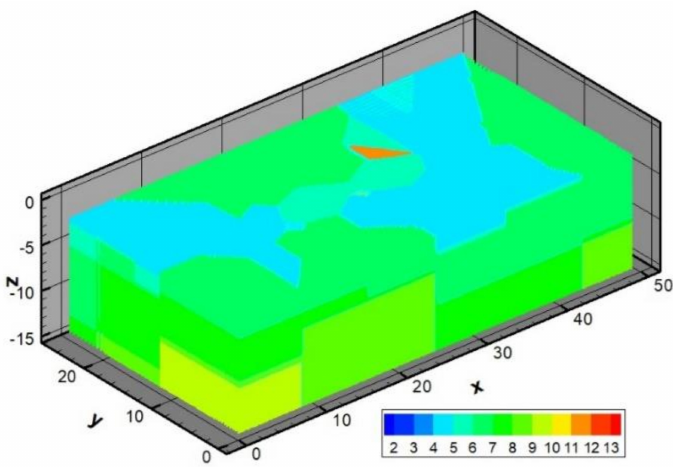
Figure 2. Soil structure in the area of the PF according to the soil numbers in Table